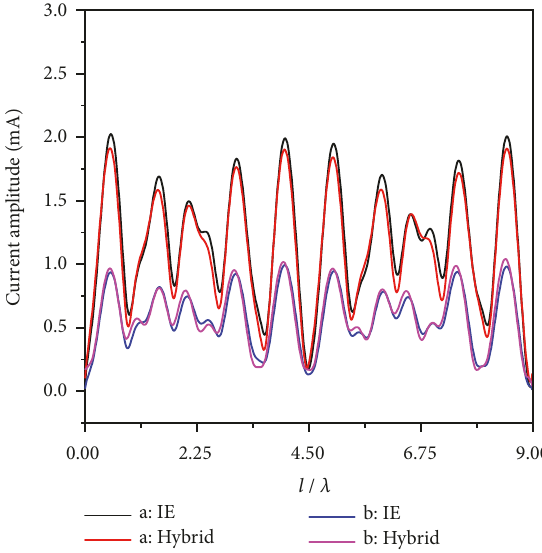
Figure 8: Currents on the straight conductor a and b